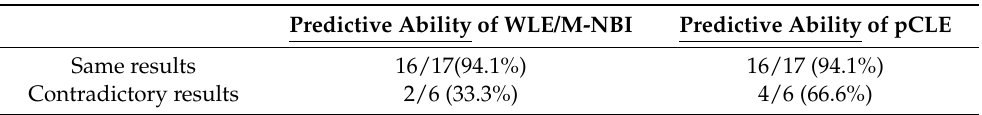
Table 3. WLE/M-NBI versus pCLE for the diagnosis of residual gastric cancer when the results were the same versus when they were